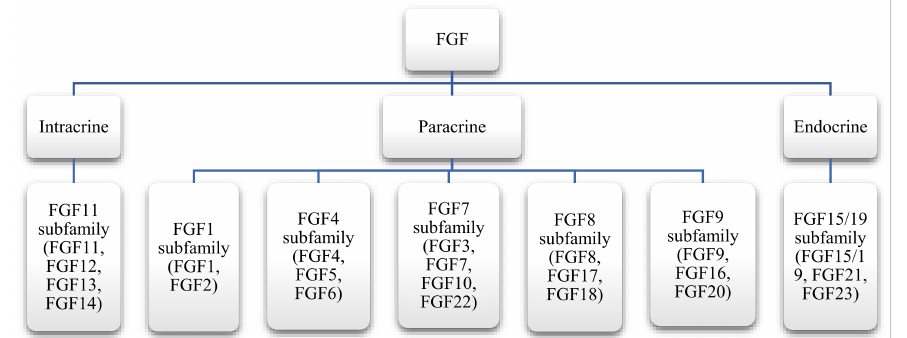
Figure 2. FGFs’ classification according to their mode of actions.